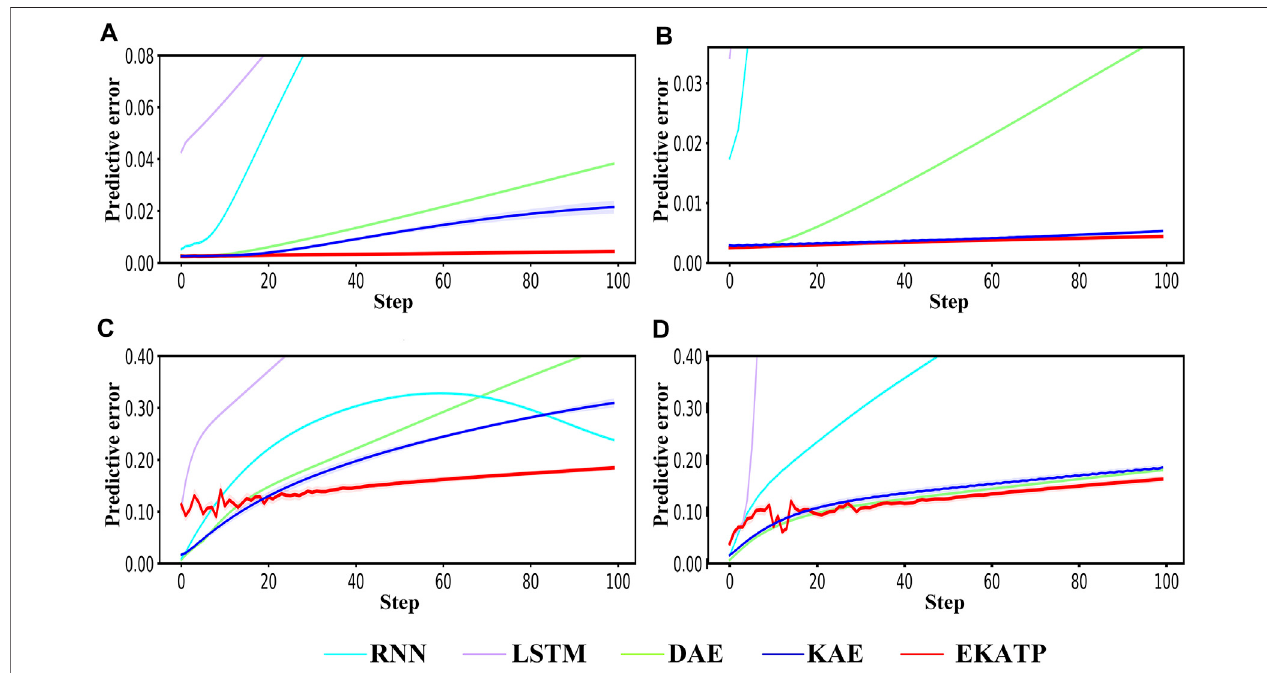
FIGURE6| ComparisonoftheRNN,LSTM,DAE,KAEandEKATP.Theabscissarepresentsthetimestep,andtheordinaterepresentsthepredictiveerror. (A) The initialconditionsare h 1 and σ (cid:1) 0.000. (B) Theinitialconditionsare h 1 and σ (cid:1) 0.001. (C) Theinitialconditionsare h 2 and σ (cid:1) 0.000. (D) Theinitialconditionsare h 2 and σ (cid:1)